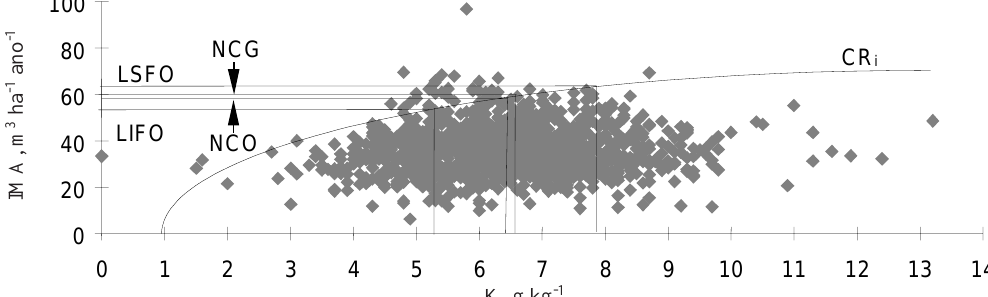
= curva de resposta ideal, NCG = nível crítico gráfico; i